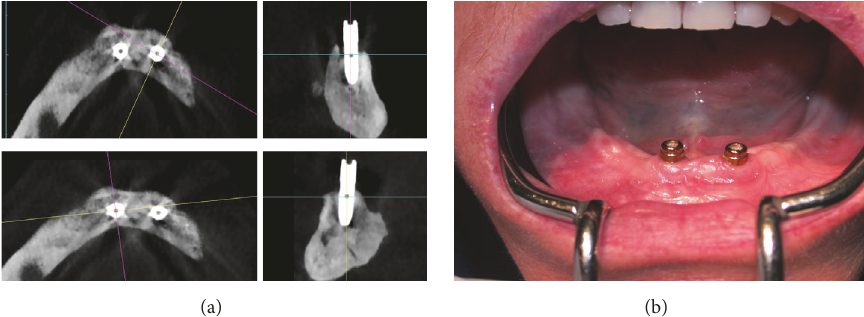
Figure 5: (a) Follow-up after surgery. CBCT images 12 months after osteomyelitis. (b) Intraoral photography showing the two dental implants without inflammation 12 months after